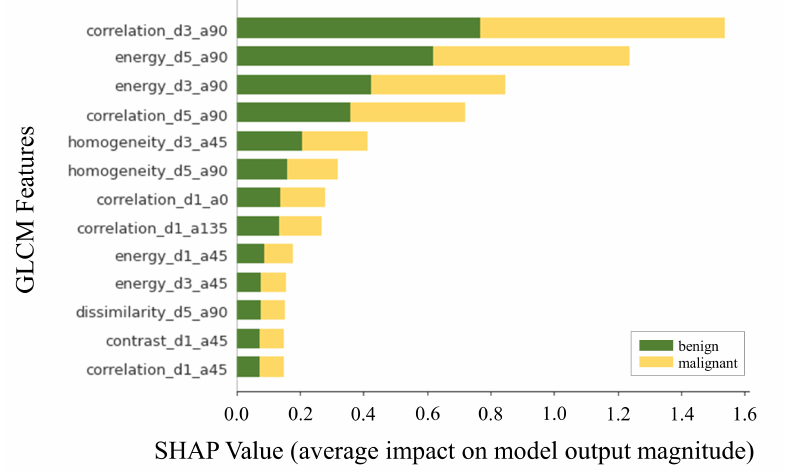
Figure 4. Feature importance. SHAP value quantifies the contribution of each feature to the prediction of each class. The features are denoted as {statistic}_d{distance}_a{angle}